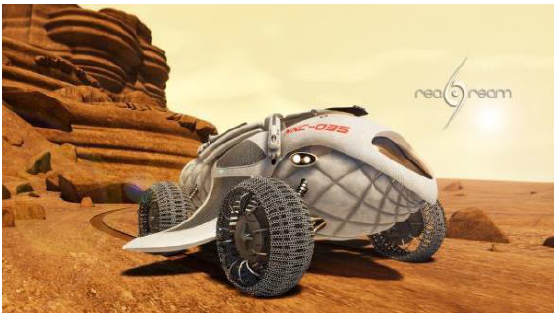
Fig. 3. Mars Service